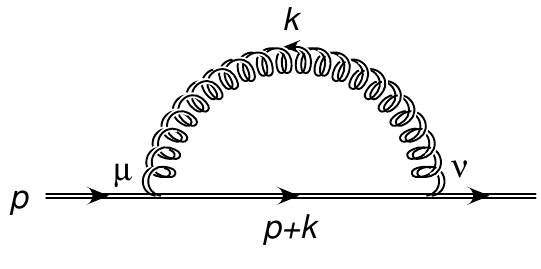
Figure 15 . One-loop self-energy Feynman diagram for the propagation of a quark of momentum p and bare mass m b , and a gluon of mass (cid:21)